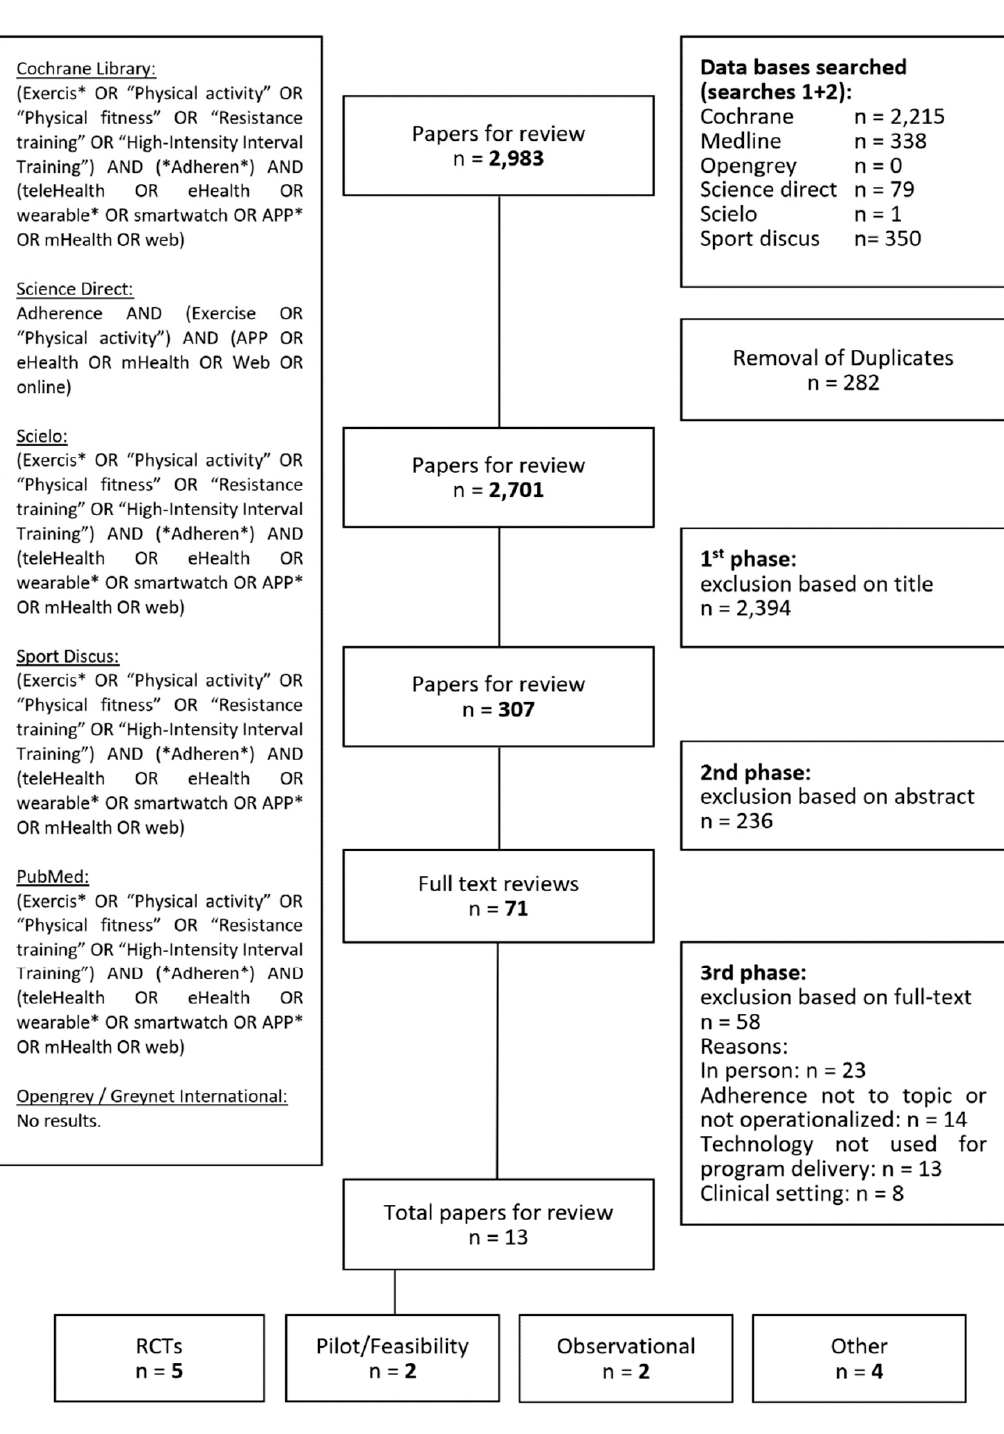
Figure 1. Scoping review strategy and